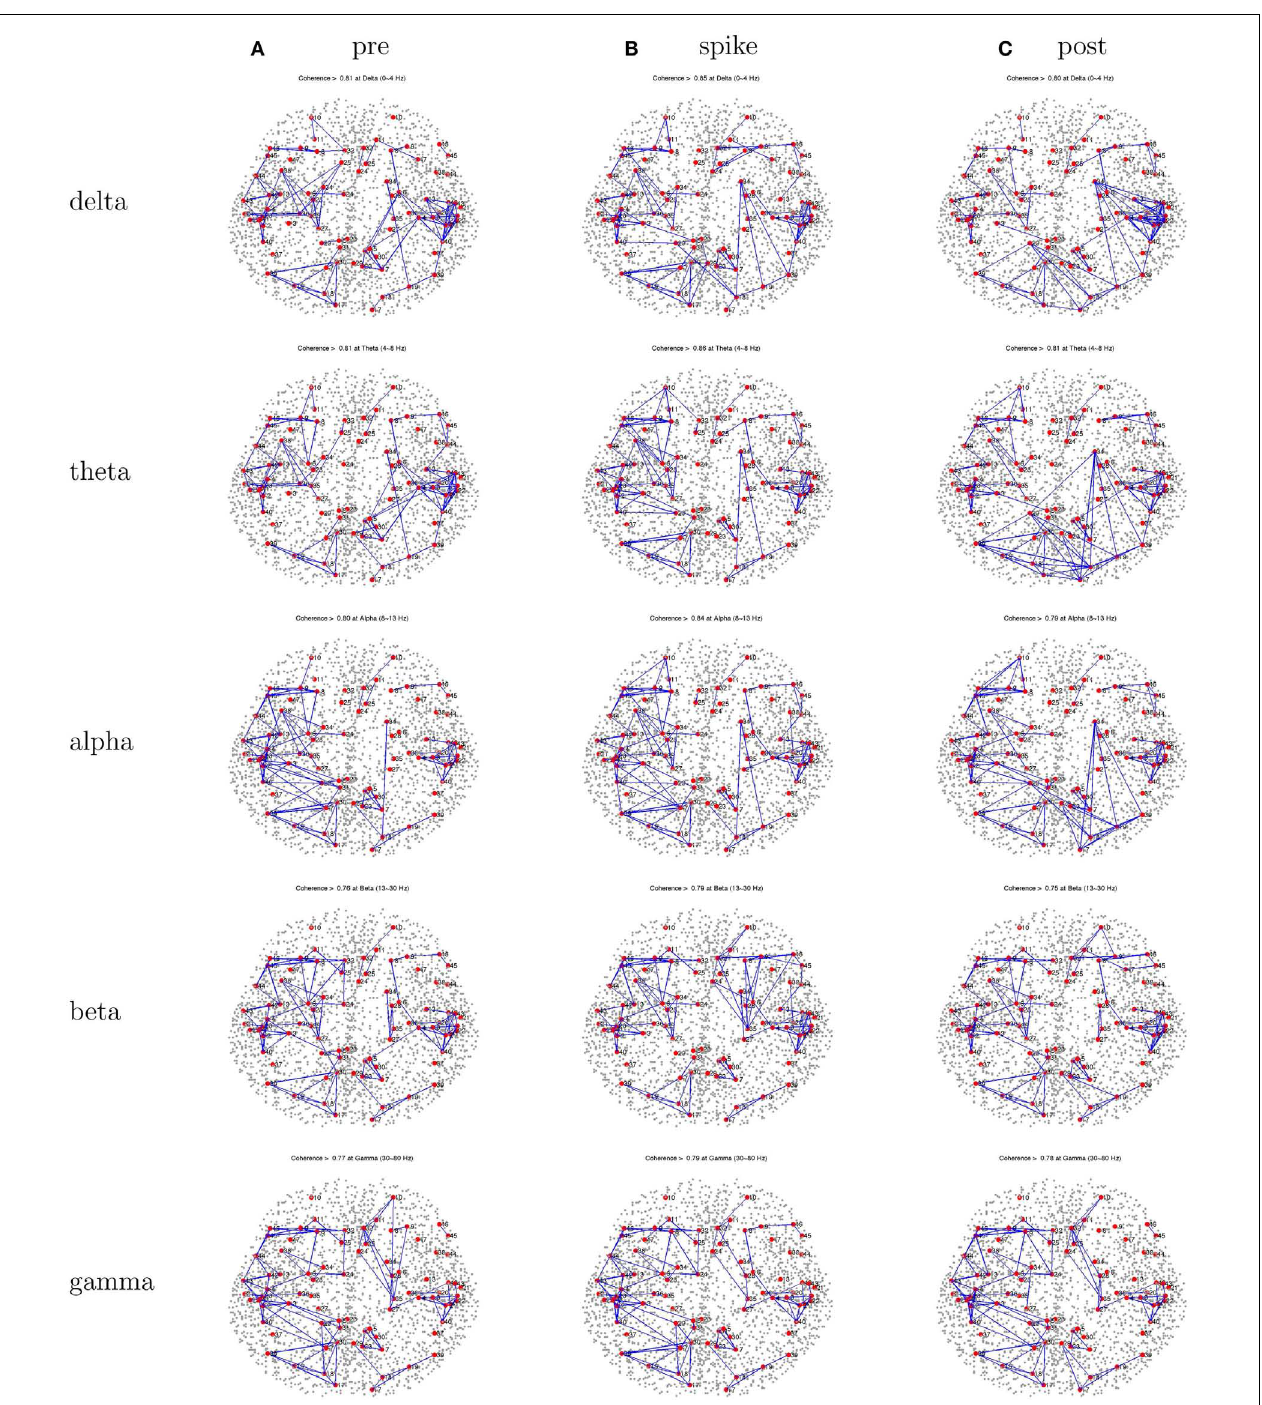
FIGURE 4 | Patient 1’s dEEG cortical source coherence peaks (highest 100 of ∼ 6400) for pre-spike (A), spike (B), and post-spike (C) intervals of the five frequency bands .